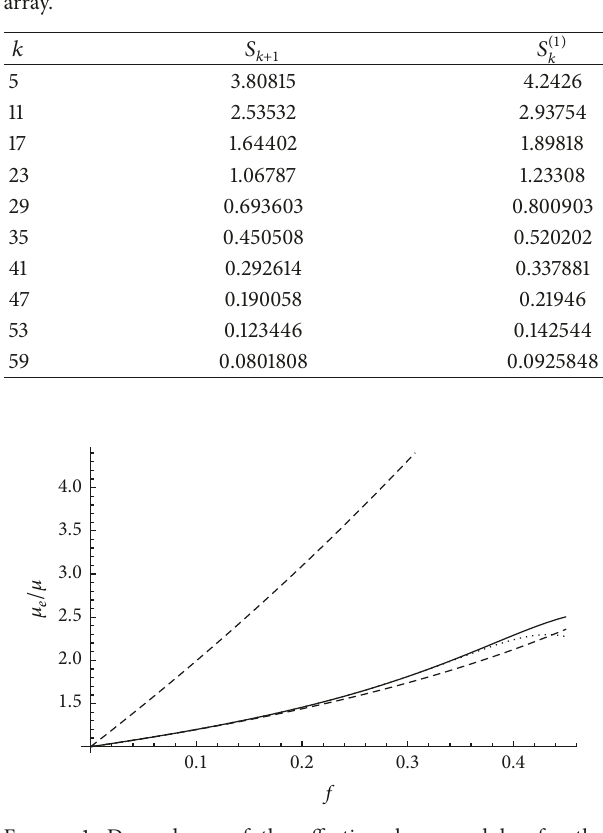
Figure 1: Dependence of the effective shear modulus for the hexagonal array on the concentration 𝑓 for 𝜌 = 0.9 . The data are computed by (85) (solid line) and its polynomial expansion up to 𝑂(𝜌 4 ) (dotted line). The Hashin-Shtrikman bounds (83) are shown by dashed